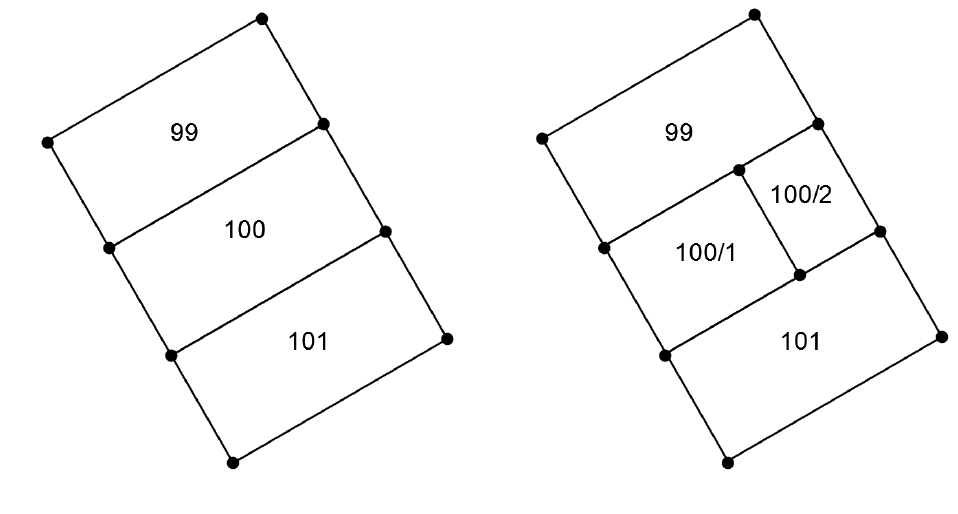
Figure 4. Simple parcel